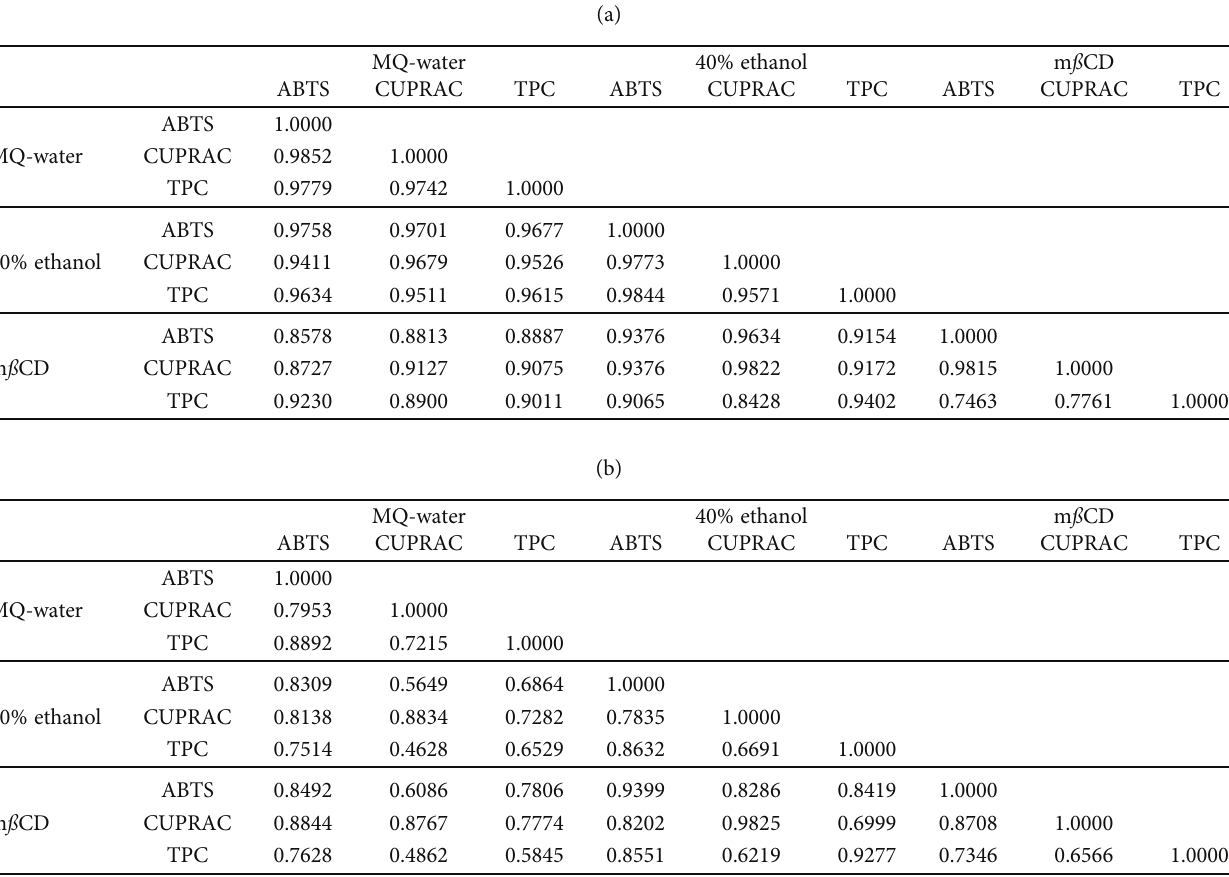
Table 3: Correlation of three assays in three di ff erent solvent systems ( ∗